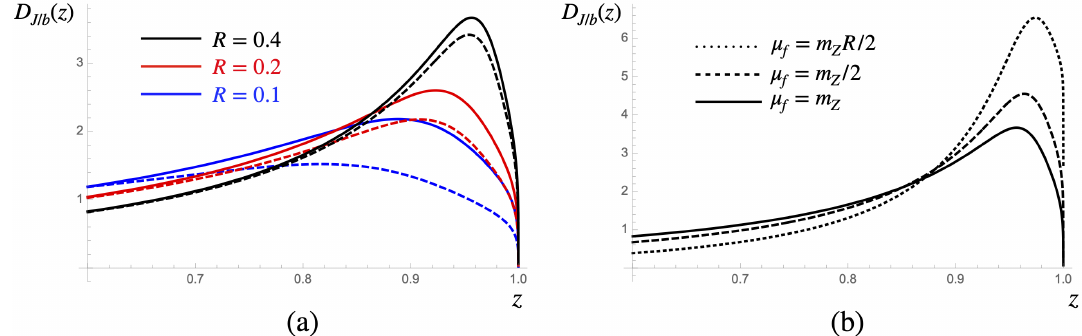
Figure 3 . The b quark FFJs near threshold for e + e − annihilation at Z pole. The maximal energy for the heavy quark jet and the factorization scale for the FFJs are respectively E max and µ f = m Z . In (a), the b quark FFJs with R = { 0 . 1 , 0 . 2 , 0 . 4 } are illustrated (solid lines) and compared with the results in the massless limit (dashed lines), while (b) shows the variance of the FFJs (with R = 0 . 4 ) for different choices of the factorization